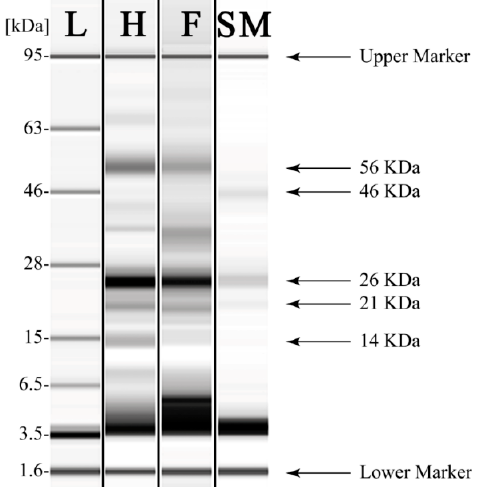
Figure 11. SDS capillary gel electrophoresis (Agilent Bioanalyzer) of proteins extracted from Lima bean healthy (H) leaves, TSSM-infested (F) Lima bean leaves, and TSSM (SM). Two clear bands of RubisCO (at 14 and 56 kDa) are evident in the leaves but almost absent in TSSMs. L, ladder. Table 3. The relative concentration of polypeptides was calculated from the capillary gel elec- trophoresis of protein extracts from healthy and TSSM-infested Lima bean leaves and from TSSMs. Values are expressed as µg ml − 1 (± standard deviation). In the same row, different letters indicate significant (P < 0.05) differences; n.c., not computable.